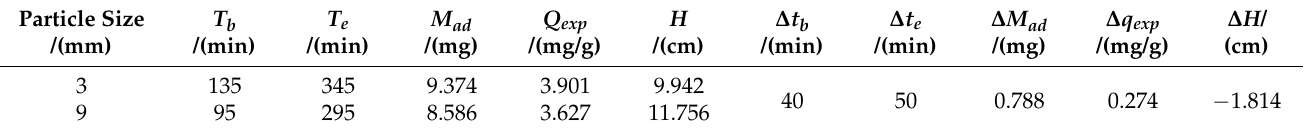
Figure 4. Effects of MBCQ with two particle sizes on the breakthrough curves. Table 3. Effects of MBCQ with two particle sizes on breakthrough time and mass transfer zone length.